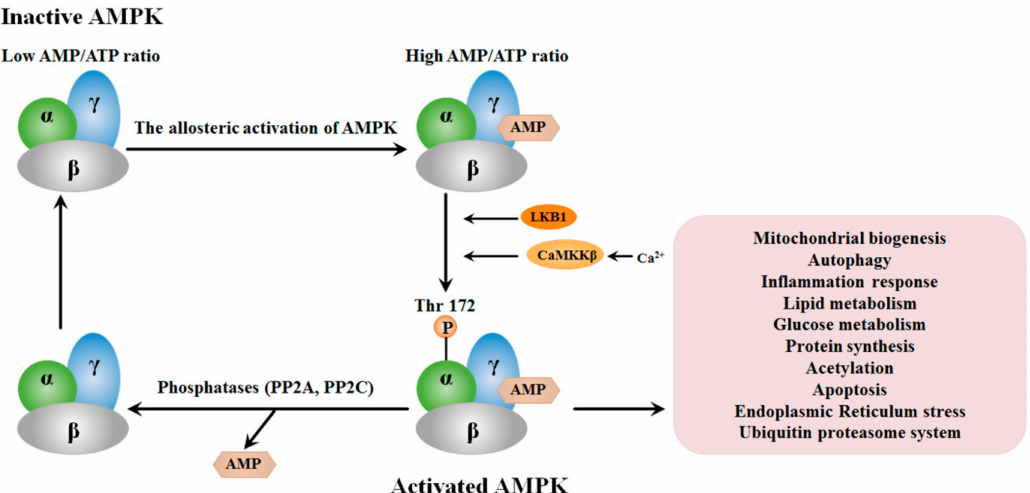
Figure 1. The structure and the activation of AMP-Activated Protein Kinase (AMPK). AMPK is composed of a catalytic α subunit and two regulatory β and γ subunits. The activation of AMPK relies on AMP-bindingtothe γ subunitandthephosphorylationofThr172onthe α subunitregulatedbyupstream kinases like CaMKK β and LKB1 and activated AMPK regulates its downstream signal